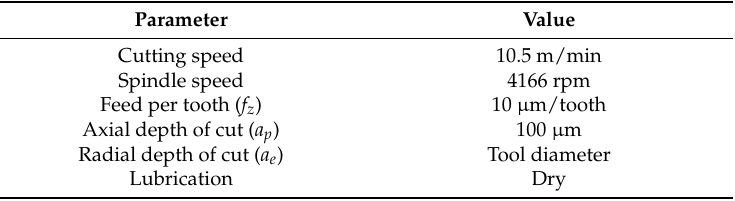
Table 3. Cutting condition utilized during the experimental tests.